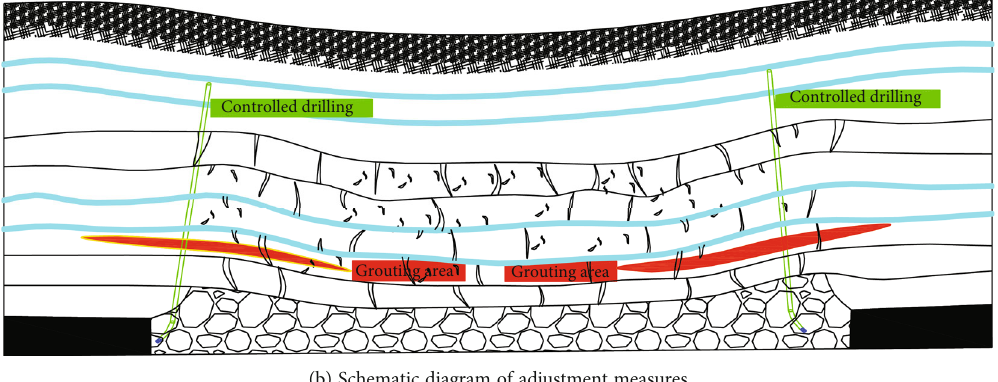
Figure 15: Schematic diagram of control method of groundwater reservoir water source based on generalization